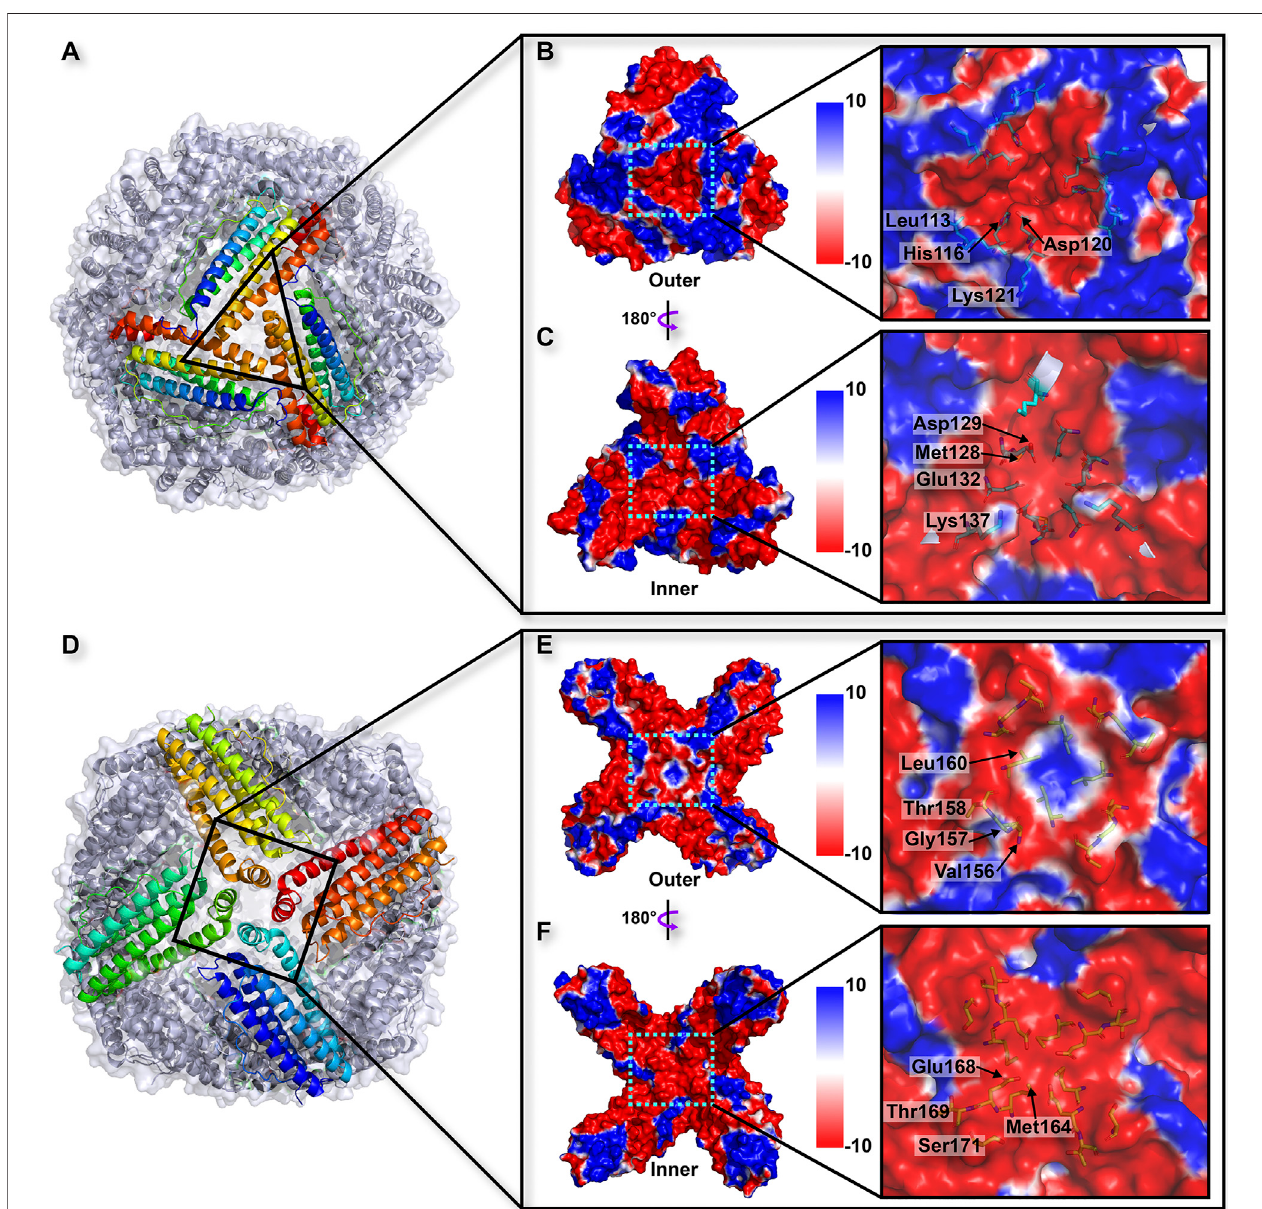
FIGURE 3 | (A) Overall structure related to the trajectory of iron entry into the TgFer nanocage through the 3-fold channel. The electrostatic surface potential from outside (B) and inside (C) of the nanocage of the 3-fold channel. (D) Overall structure of TgFer nanocage through the 4-fold channel. The electrostatic surface potential from outside (E) and inside (F) of the cage at the 4-fold channel. The potential scale is rendered from the − 10 kTe − 1 to +10 kTe − 1 from red to